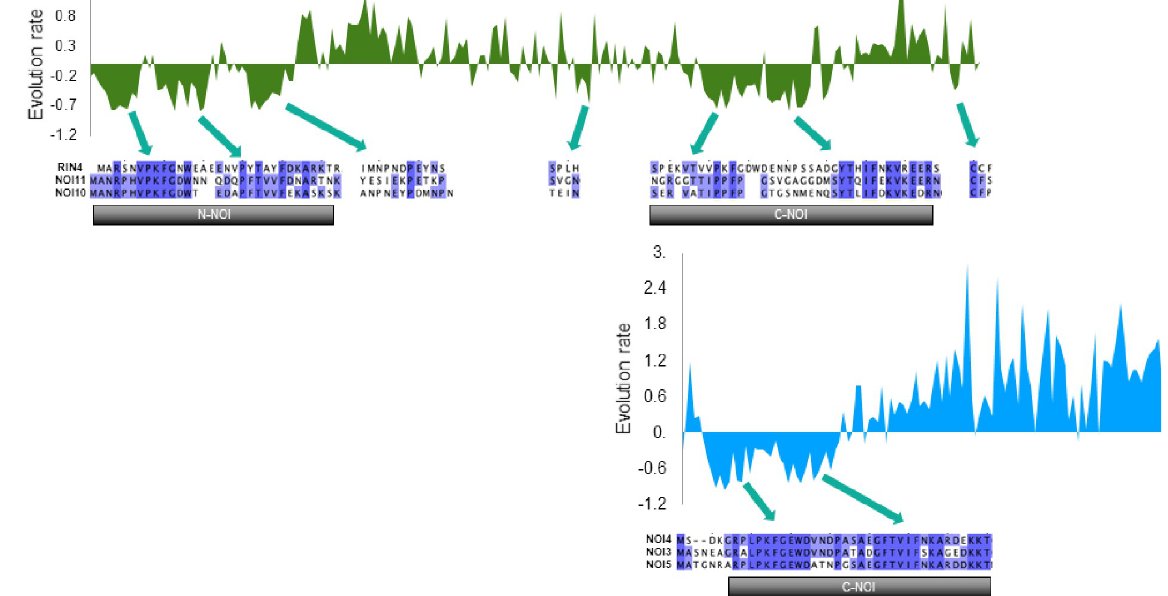
Fig 5. Amino acid evolution. Rate per site for long two-NOI sequences (dark green) and short one-NOI sequences (light blue) from dicot species. Partial alignments of the reference sequences, RIN4 for long two-NOI and NOI4 for short one-NOI, with the mite-induced members are shown below the negative evolution rates.